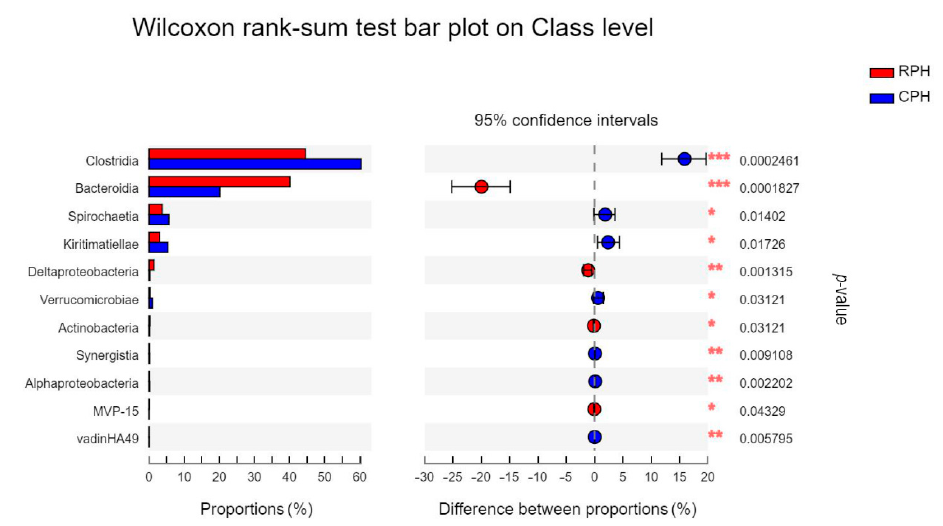
Figure 7. The bar plot shows the bacterial class with significant differences among the CPH and RPH. * p < 0.05, ** p < 0.01 and *** p < 0.001.